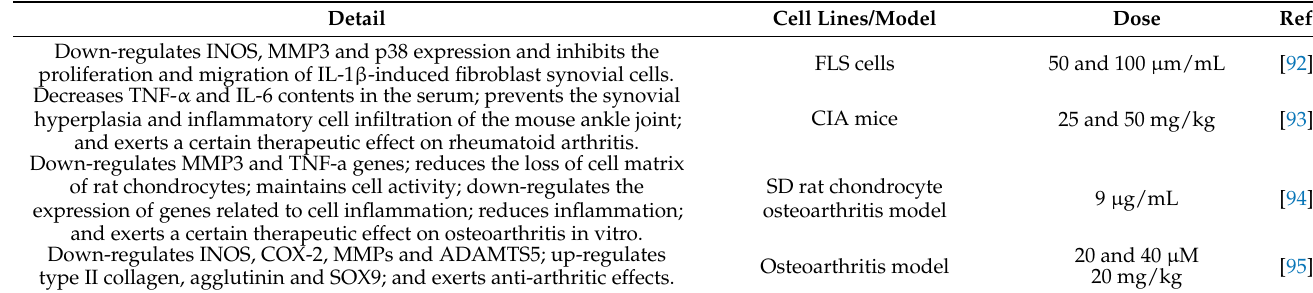
Table 10. Joint-Protective Activity of